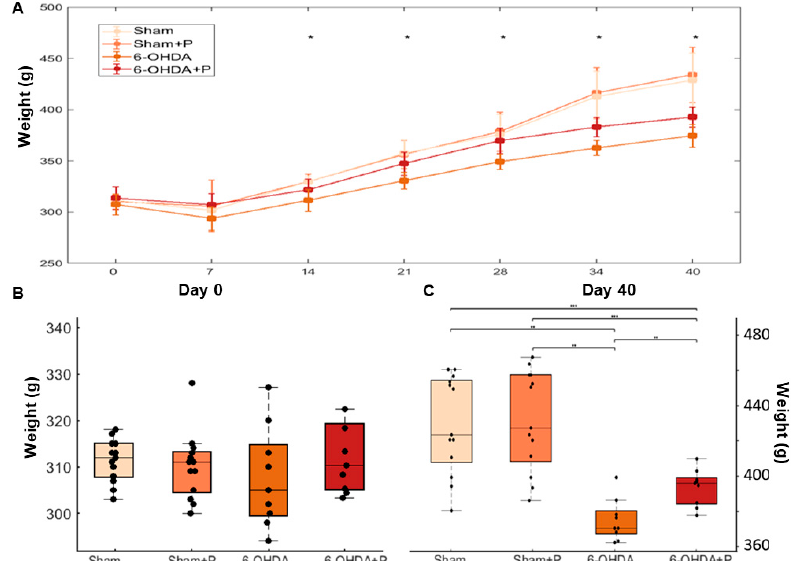
Figure 10. Statistical analysis of evolution of animal weights during the experimental period of 40 days. ( A ) Average weight with standard deviation (groups: sham, n = 13; sham+P, n = 13; 6-OHDA, n = 9; 6-OHDA+P, n = 9). The asterisks indicate a significant difference between groups (* p < 0.05). Day 0: chi-square = 2.2876, p = 0.5149; day 7: chi-square = 5.4888, p = 0.1393; day 14: chi-square = 14.8267, p = 0.0019709; day 21: chi-square = 17.6751, p = 0.00051; day 28: chi-square = 19.057, p = 0.000266; day 34: chi-square = 25.7706, p = 0.00001065; day 40: chi-square = 25.7568, p = 0.0000107. ( B ) Distribution of the animals’ body weight of all groups on the first day of measurement. The mean and standard deviation were as follows: 311.3 ± 4.392 (sham); 310.2 ± 6.9 (sham + P); 307.7 ± 10.2 (6-OHDA); 313.7 ± 11.11 (6-OHDA + P). ( C ) Distribution of the animals’ body weight of all groups on day 40 of measurement. The mean and standard deviation were as follows: 428.8 ± 26.6 (sham); 434.2 ± 27.13 (sham + P); 374.7 ± 11.15 (6-OHDA); 392.8 ± 9.704 (6-OHDA +